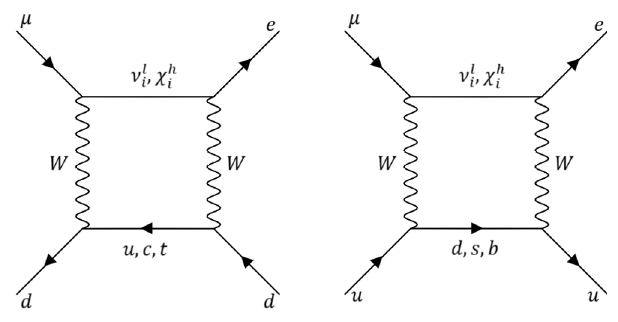
Figure 5 . Box diagrams contributing to µ − e conversion in nuclei considering light-heavy Majorana